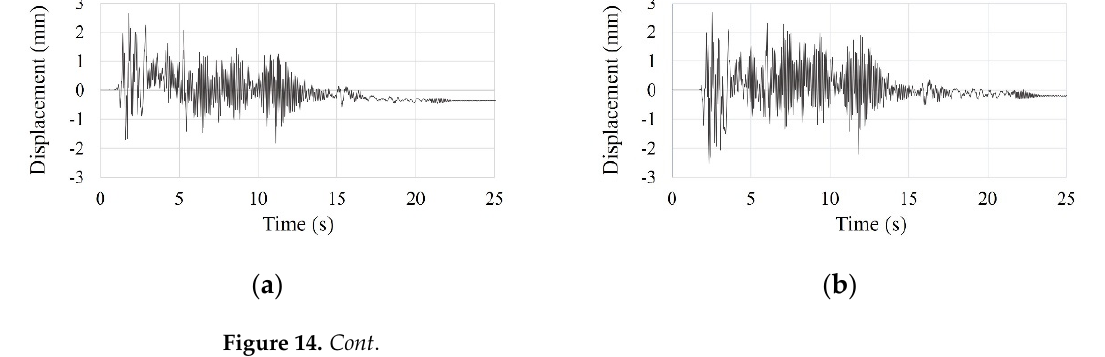
Figure 13. Time history curve of the SDOF model by scaled El Centro earthquake vibration test: ( a ) first test; ( b ) second test; ( c ) third test; ( d ) fourth test; ( e ) five test; ( f ) overlapping entire tests.